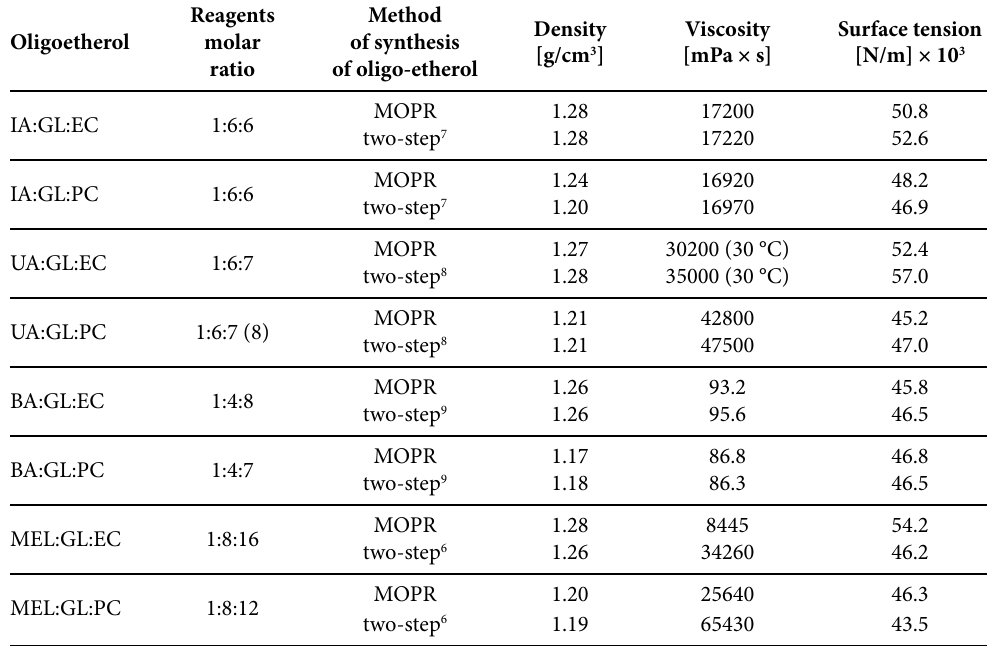
Table 3. The physical properties of oligoetherols at 20 °C obtained various methods in the reaction of azacycles with GL and AC